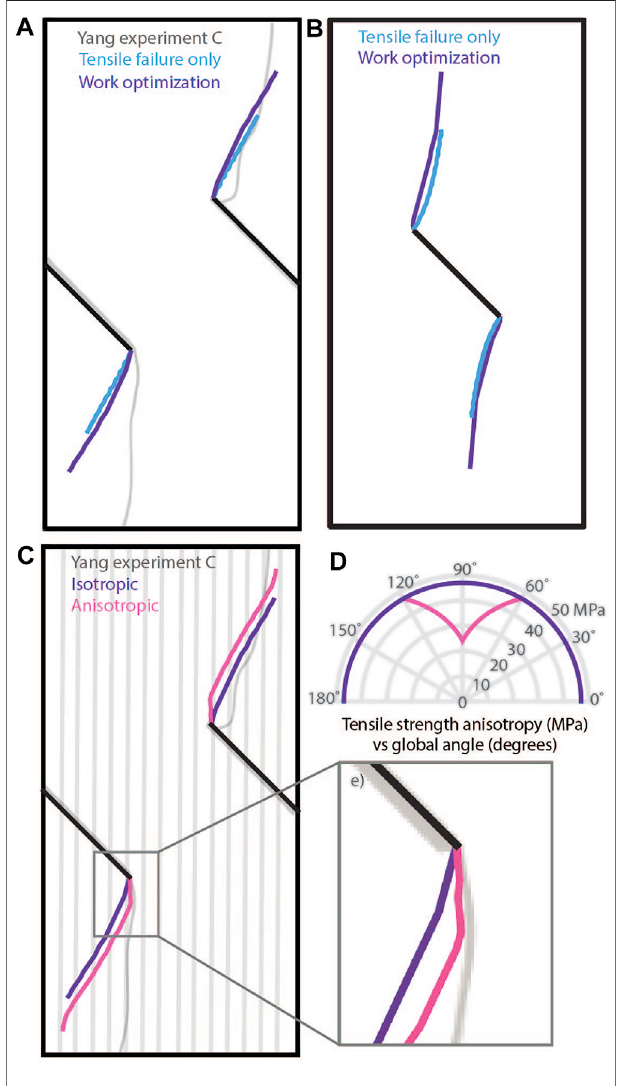
FIGURE 5 | (A) Simulations of fracture growth using only tensile failure and using work optimization, including both tensile and shear failure in an isotropic, homogeneous model with pre-cut fractures matching geometry of Yang et al. (2009) experiment C. (B) Models ofpropagation paths from a center crack. (C) Work optimized propagation path from model with isotropic tensile strength compared to model with anisotropic tensile strength. (D) Tensile strength relative to a global reference frame. (E) Detail of work optimized crack growth from pre-cut fracture tip.